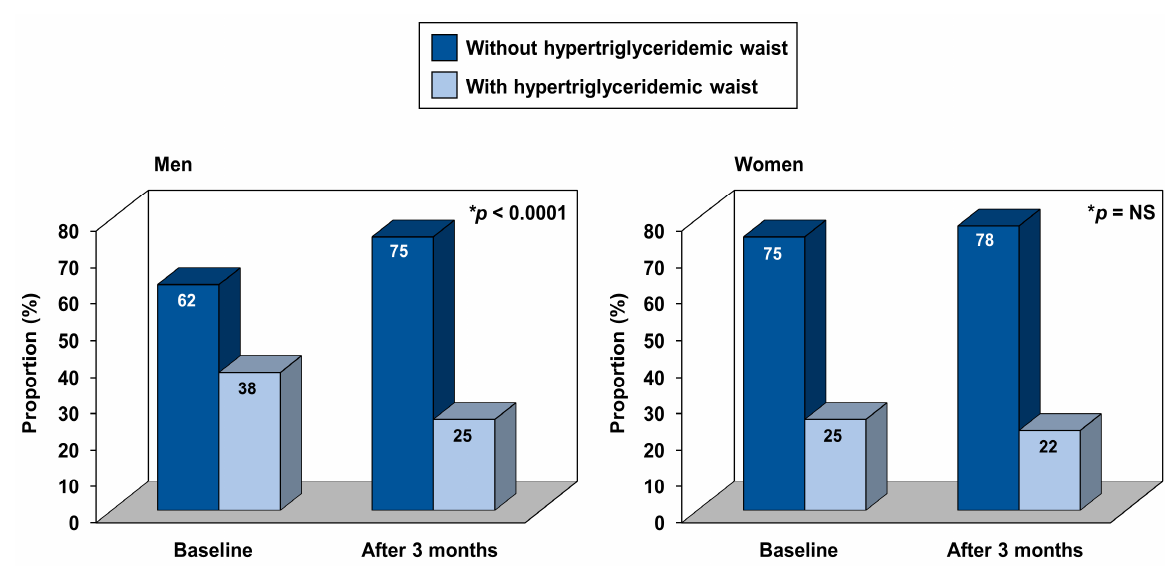
Figure 2. Changes in carriers of the hypertriglyceridemic waist phenotype in response to the 3-month lifestyle modification program. * The statistical difference has been quantified according to the McNemar’s test.